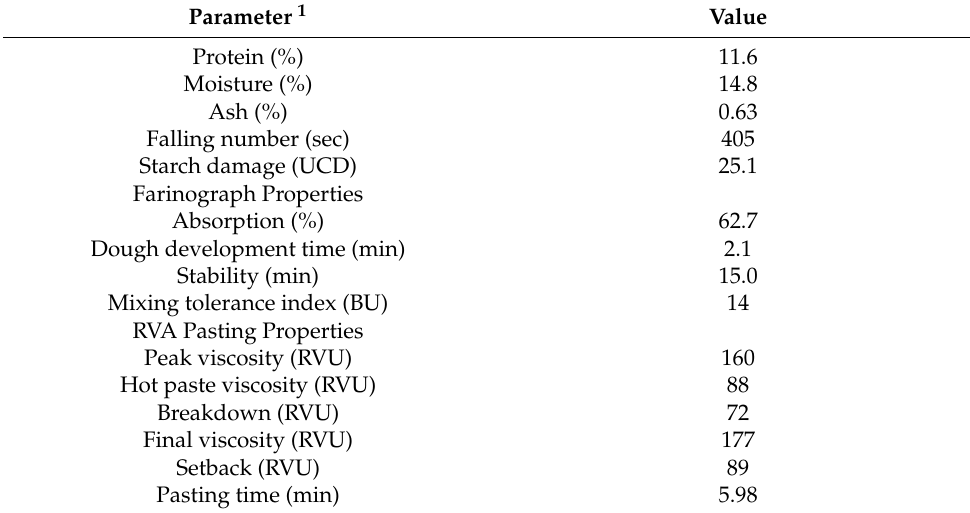
Table 6. Flour quality parameters.